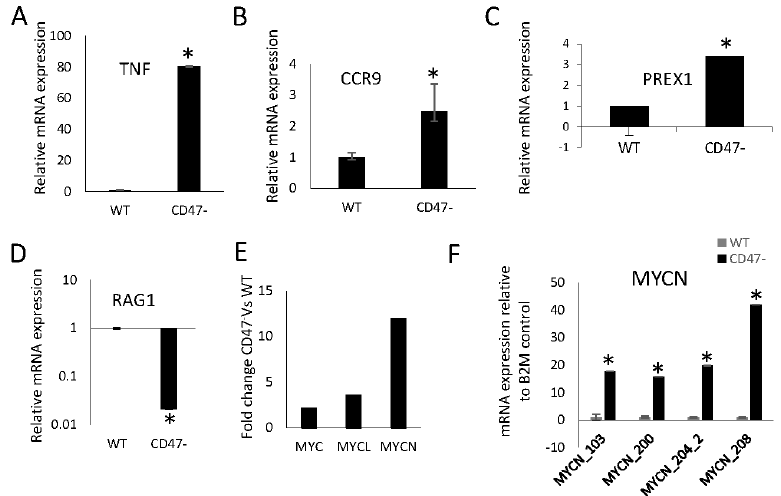
Figure 1. Validation of CD47-dependent genes identified by RNAseq in Jurkat T lymphoblasts. WT and CD47 − Jurkat T cells were activated on immobilized CD3 and CD28 antibodies and treated in the presence or absence of TSP1 for the indicated times. ( A – D ) Validation of differentially expressed genes (Supplementary Figure S1D), TNF , CCR9 , PREX 1, and RAG 1 using WT and CD47 − Jurkat T cells via real-time PCR using B2M as the control. ( E ) Fold change in MYC, MYCN, and MYCL between WT and CD47 − Jurkat T cells via RNA sequencing (Supplementary Data S1). ( F ) Relative expression of MYCN mRNA determined using real-time PCR between WT and CD47- Jurkat T lymphoblasts. Error bars indicate technical replicates (* = p -values ≤ 0.05, n =